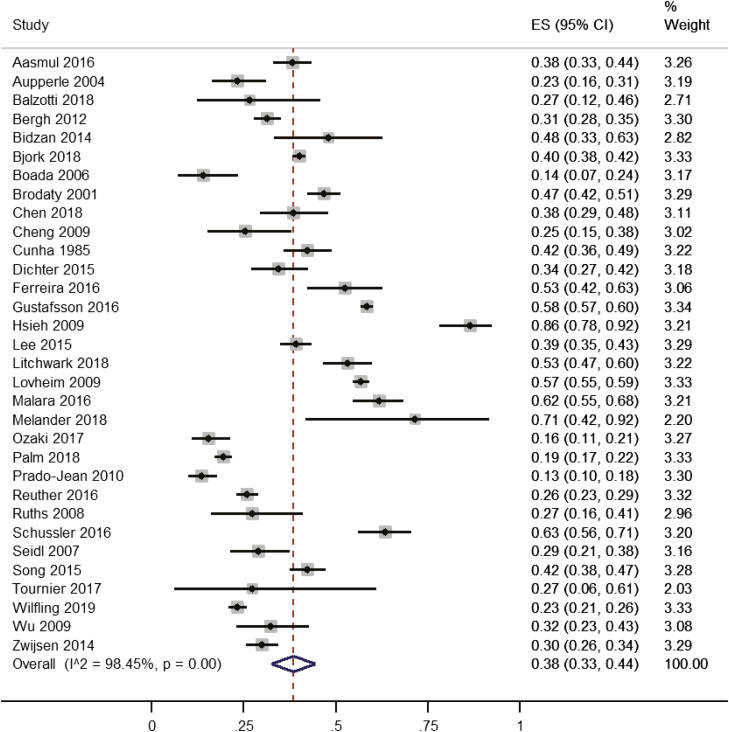
Forest plot of the prevalence of symptoms of sleep disturbances in people with dementia living in care homes measured by validated questionnaires. ES, effect size.